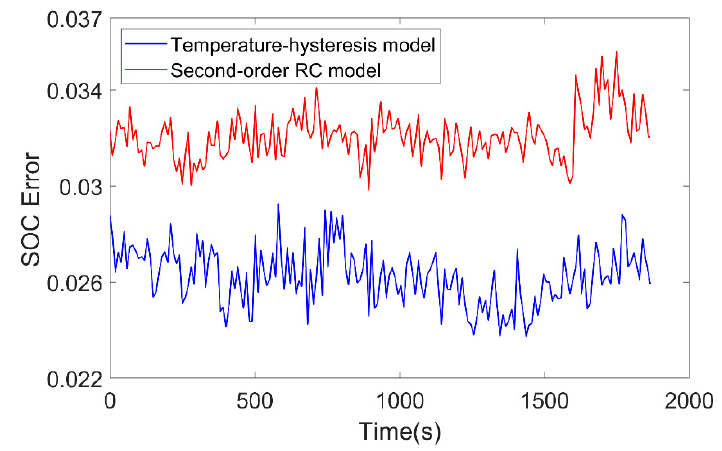
Figure 19. SOC estimation error at 25 °C.